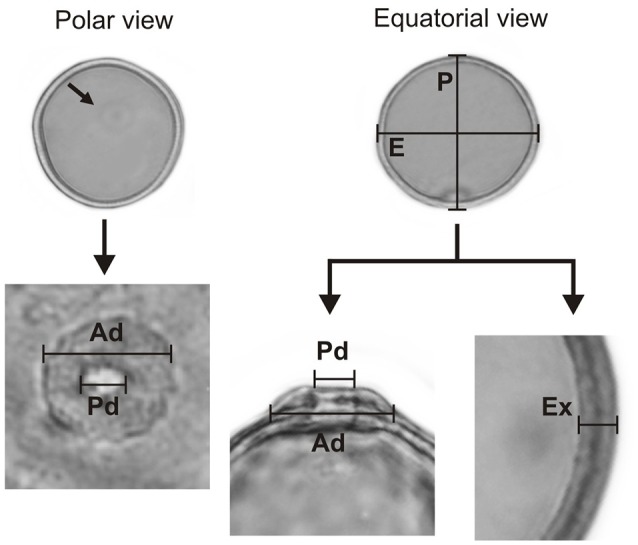
The parameters of a Poaceae pollen grain are considered in the present paper. Polar diameter (P), equatorial diameter (E), pore diameter (Pd), annulus diameter (Ad), and exine thickness (Ex).